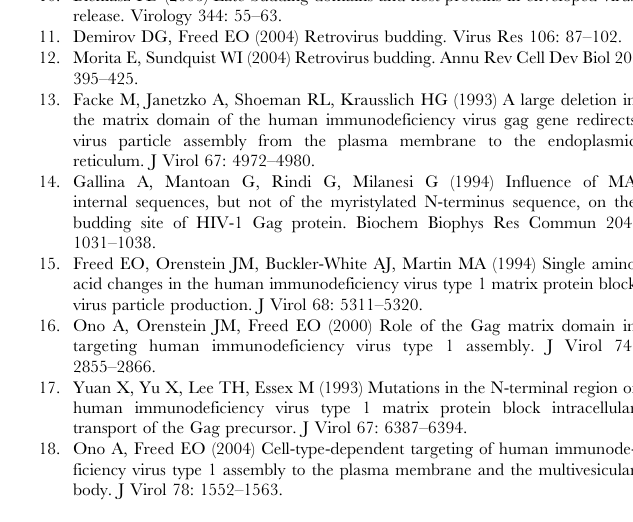
Projection mode from the image processing software OsiriX. The image in this figure corresponds to Fig. 6A, bottom. Found at: doi:10.1371/journal.ppat.1000015.s006 (0.38 MB MOV) Video S4 Analysis of Gag localization in 3D. The z-series reconstructions were obtained by using the Maximum Intensity Projection mode from the image processing software OsiriX. The image in this figure corresponds to Fig. 6A, top. Found at: doi:10.1371/journal.ppat.1000015.s007 (0.16 MB MOV) Video S5 Analysis of Gag localization in 3D. The z-series reconstructions were obtained by using the Maximum Intensity Projection mode from the image processing software OsiriX. The image in this figure corresponds to Fig. 7A. Found at: doi:10.1371/journal.ppat.1000015.s008 (0.30 MB MOV) Video S6 Analysis of Gag localization in 3D. The z-series reconstructions were obtained by using the Maximum Intensity Projection mode from the image processing software OsiriX. The image in this figure corresponds to Fig. 8, top. Found at: doi:10.1371/journal.ppat.1000015.s009 (0.13 MB MOV) Video S7 Movie of Gag movement to the MDM/MDM and MDM/T-cell synapse. This experiment corresponds to the gallery presented in Fig. 9A.